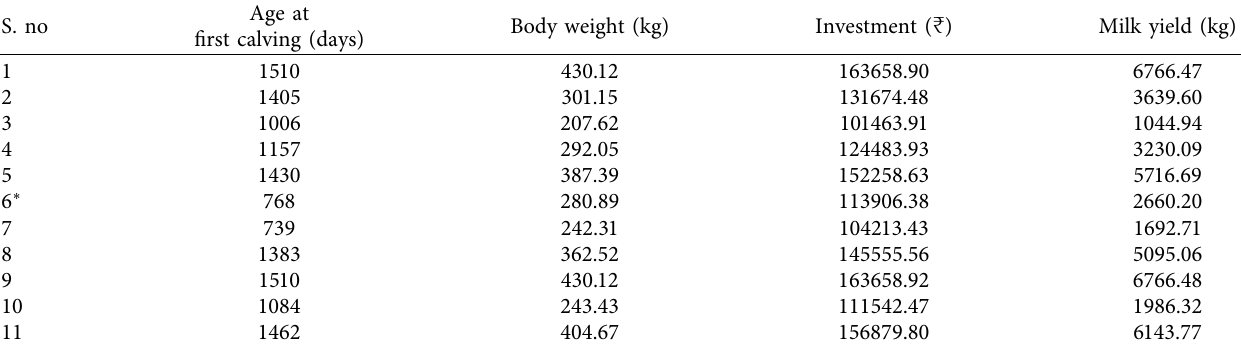
Table 5: Optimized solution sets generated by GA.